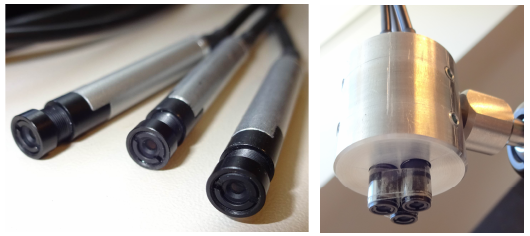
Figure 1. Awaiba NanEyeGS and